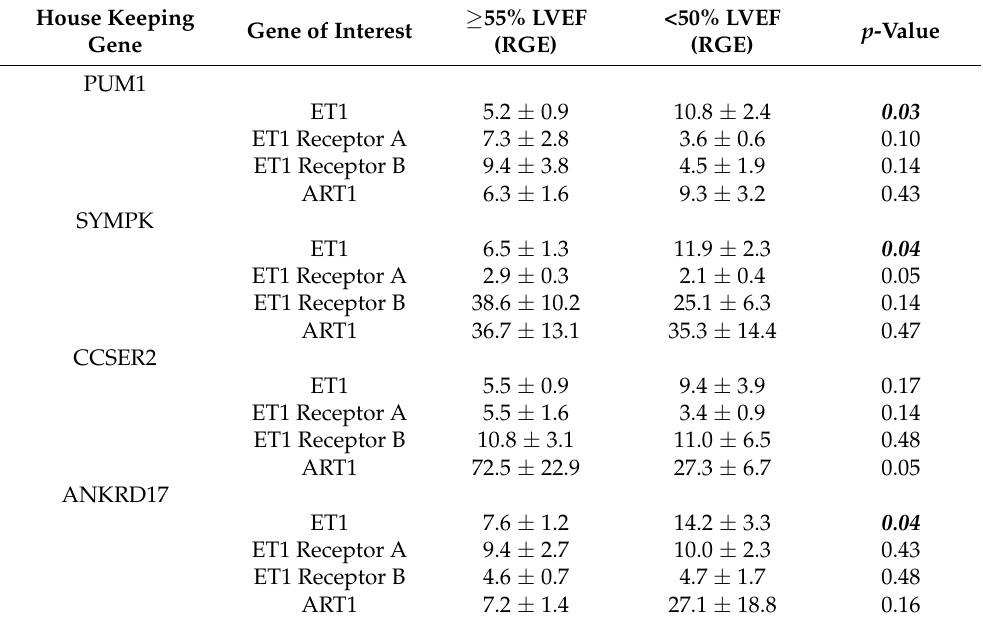
Figure 2. Expression of ET1, Big ET1 and ATR1 staining in breast tumor tissue. ( A ) Representative photo of IHC showing positive staining for ET1 (red arrow). ( B ) Representative photo of IHC showing positive staining for Big ET1 (red arrow). ( C ) Representative photo of IHC staining for ATR1 (red arrow). ( D ) Mean positive immunohistochemistry staining (%) for ET1, Big ET1 and ATR1 in breast tumor tissue normalized to the tumor tissue area. n = 33, ****, p < 0.0001. Table 2. Relationship between LVEF of >55% or ≤ 50% and genes of interest using different house- keeping genes in tumor